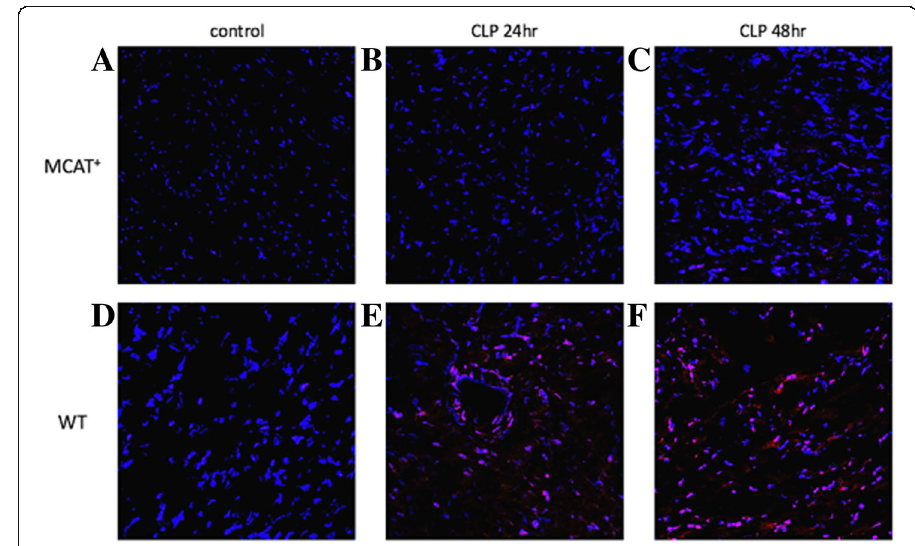
Fig. 4 Photomicrographs of heart sections stained with dihydroethidium (DHE) in red and DAPI in blue (merged images) from septic MCAT +/+ ( a , b , c ) and WT mice ( d , e , f ). Significant increase in level of oxidative stress (signified by increased uptake of DHE) in the WT mice at 24 ( e ) and 48 h ( f ) following CLP. Minimal signs of oxidative stress are seen the MCAT +/+ mice following CLP